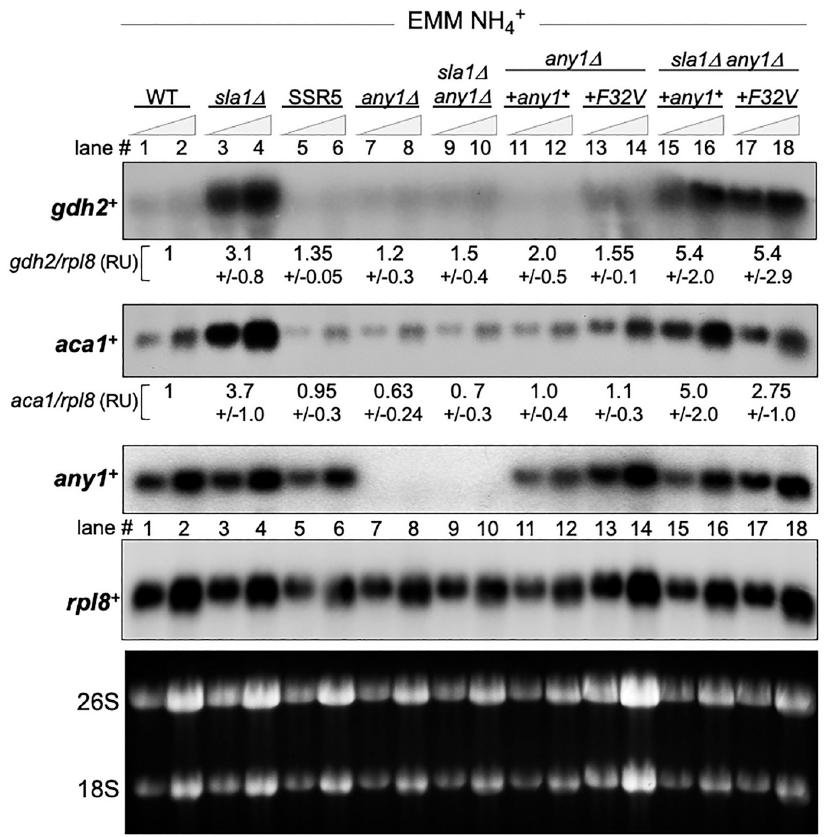
Fig 5. Evidence that any1-F32V may selectively suppress aca1 + gene expression in sla1 Δ cells. A northern blot of 5 and 10 μ g of total RNA from cells grown in EMM-NH4 + , as in Fig 2. The strains are as described in Fig 4. The quantification values indicated under the lanes of the gdh2 + and aca1 + panels were derived from two biological experiments each containing measurements of two separate RNA sample loadings calibrated by the loading control rpl8 + mRNA in each lane and reported as relative units (RU). The lower panel shows the ethidium stained agarose gel prior to transfer.